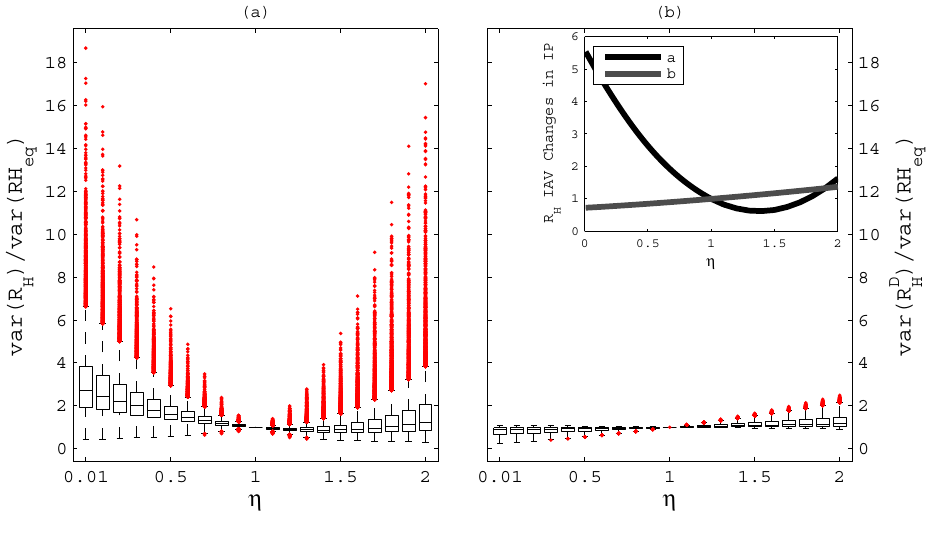
Fig. 6. Influence of distance to equilibrium ( η ) in the IAV of heterotrophic respiration ( R H ) fluxes (a) and in the IAV of the de-trended R H fluxes ( R D ), removing the sole recovery from the C pools) (b) . Each vertical rectangular box represents the spatial distribution of the H IAV ratio indicated in the yy-axis for Iberian Peninsula (all pixels). Rectangular boxes are bounded by 25 and 75 percentile bottom and top, respectively, while the horizontal line inside indicates the sample median; dashed lines limited by horizontal bars indicate the extent of the remaining data, excluding outliers; dot signs ( • ) indicate statistical outliers. The inset in (b) shows for a spatial average of all the Iberian Peninsula the ratio between the IAV of R H and the IAV of RH eq (black line a) and the ratio between the IAV of R D (grey line